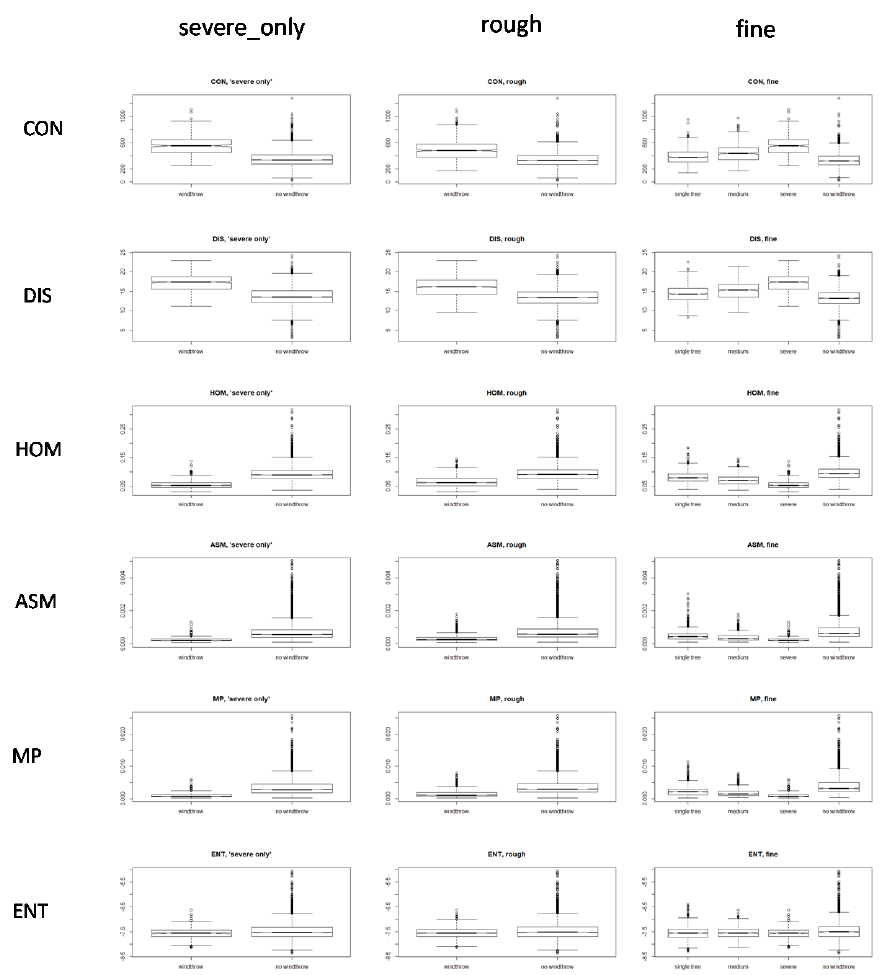
Figure 3. Boxplots for texture metric distributions. In the left column, “severe only” cells are combined. In the middle column, “severe only” and “medium” cells are combined. In the right column, the distributions for all categories (see Table 4) are shown in a comparative manner. Table 5. Mean values and p -values for the Welsh t -test for the calculated texture metrics in “severe only” and “rough” groups.